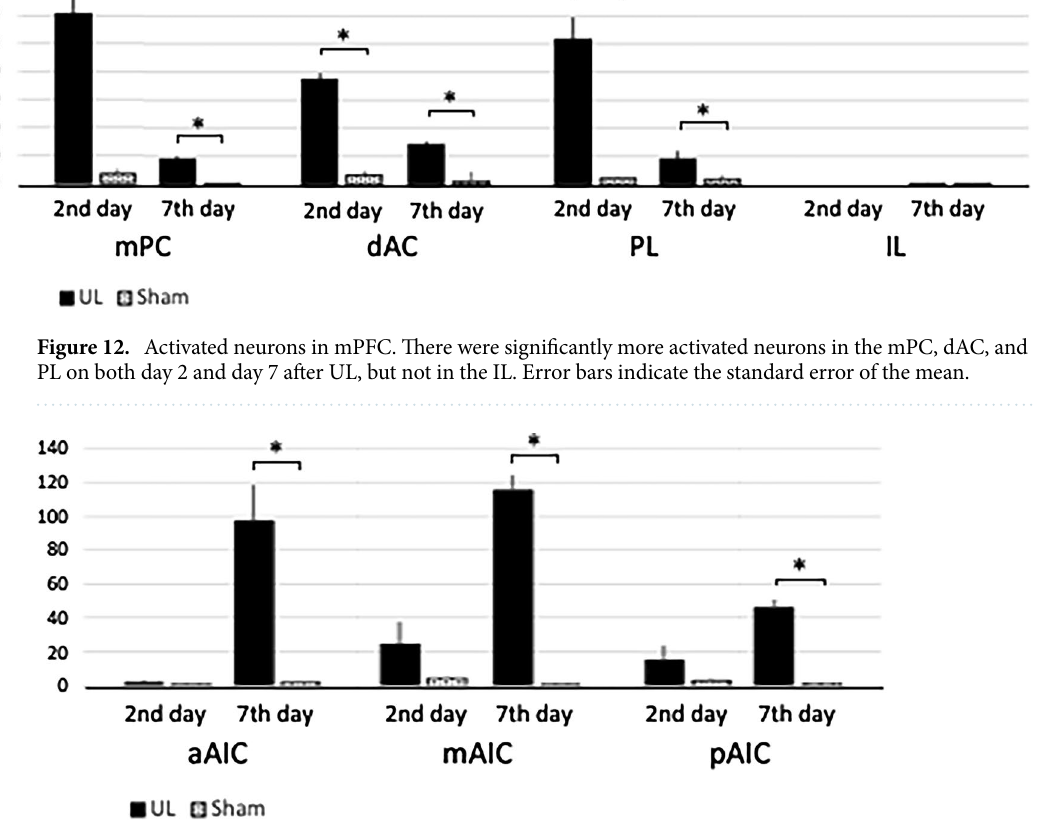
Figure 13. Activated neurons in AIC. There were no significant differences between the UL and the sham- treated group for any of the AIC subregions on day 2 after UL. However, there were significantly more activated neurons in all of the subregions on day 7 after UL. Error bars indicate the standard error of the